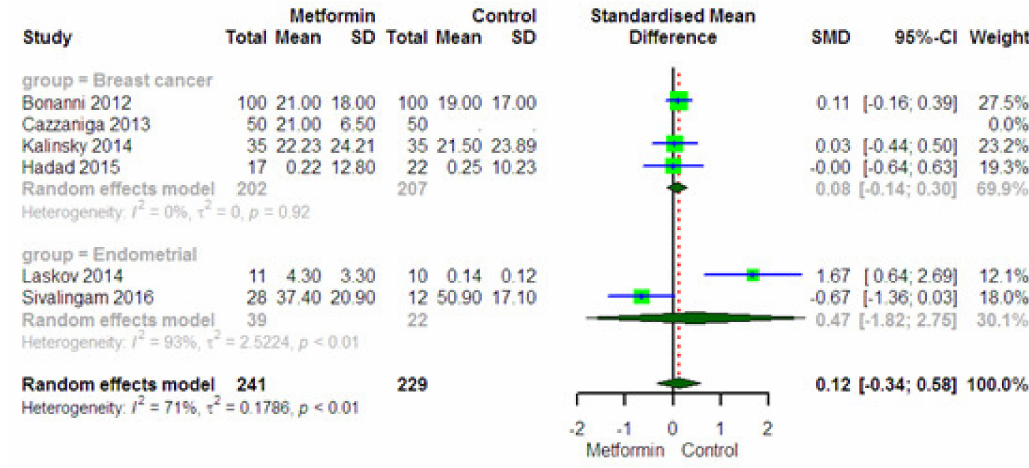
Figure 6. Forest plot of the meta-analysis to compare plasma Ki-67 levels between intervention and control